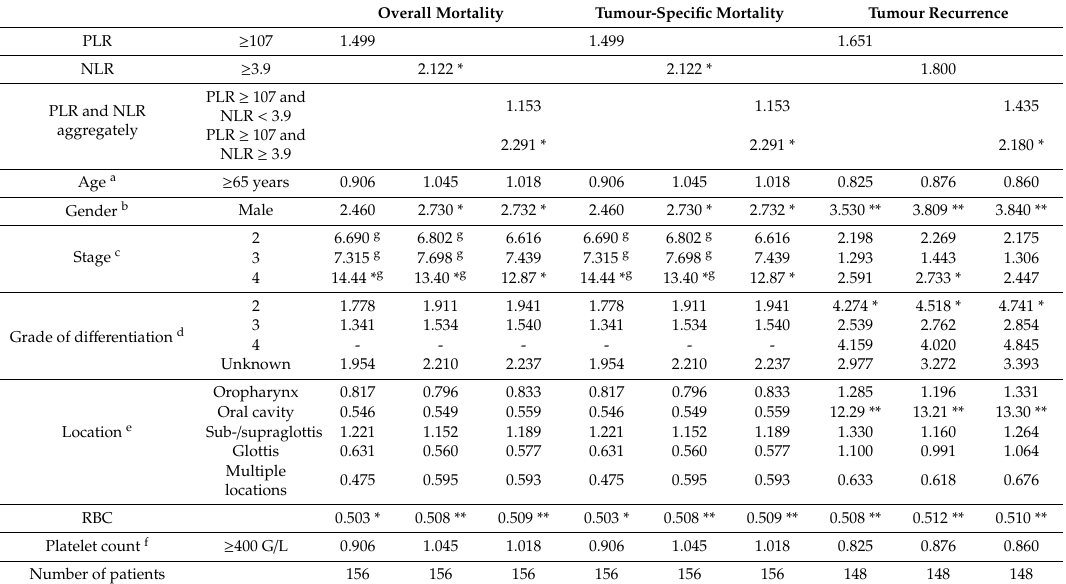
Table 2. Multivariate Cox regression analysis of five-year and of tumour-specific mortality, and of tumour